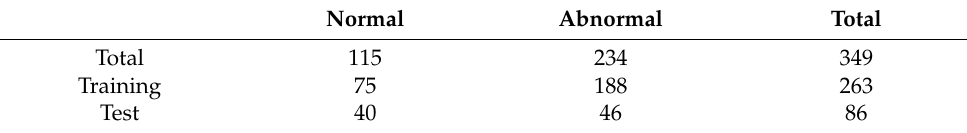
Table 2. Training and test data